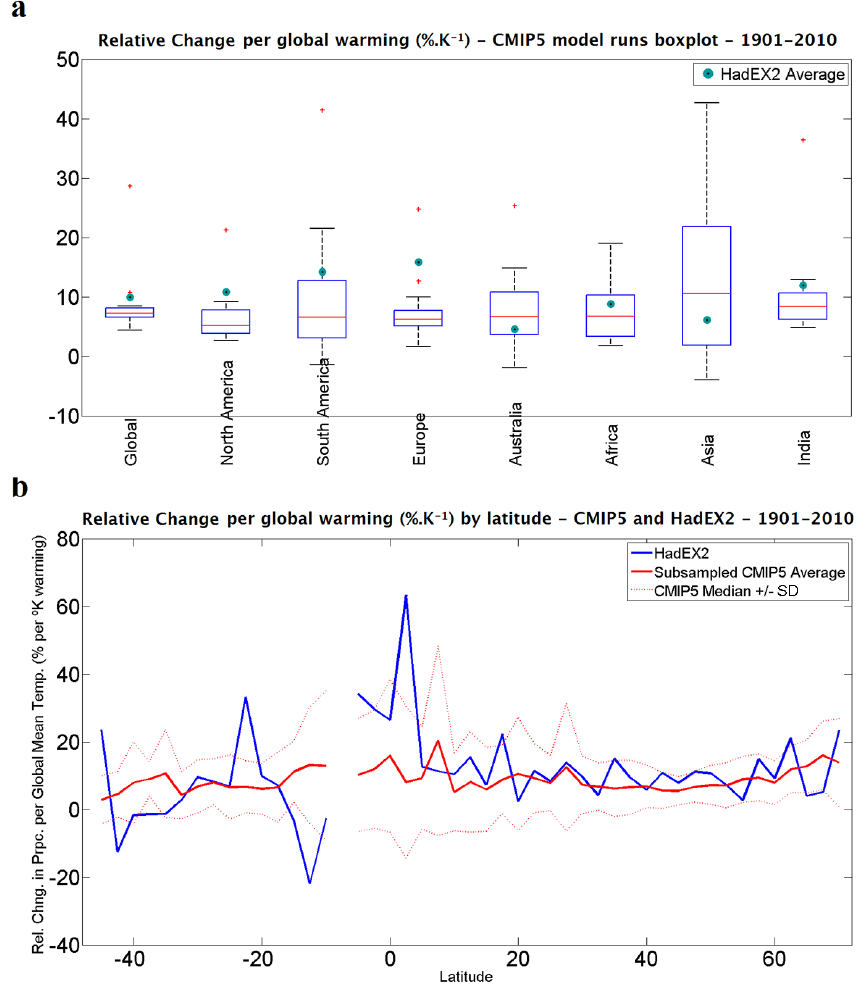
Figure 8. Relative change in extreme precipitation per K of global warming (%K − 1 ) in 1901–2010 – (a) boxplots of CMIP5 model run averaged results (minimum, 25th percentile, median, 75th percentile and maximum of the 19 model runs) as well as the average of HadEX2 observational data (shown as blue circles) on global and continental scales and (b) average changes at each 2.5 ◦ latitudinal